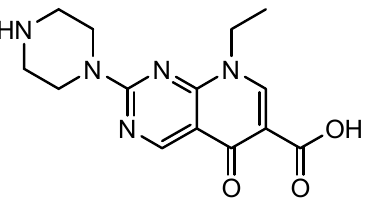
Figure 1. Molecular structure of pipemidic acid (pipH).